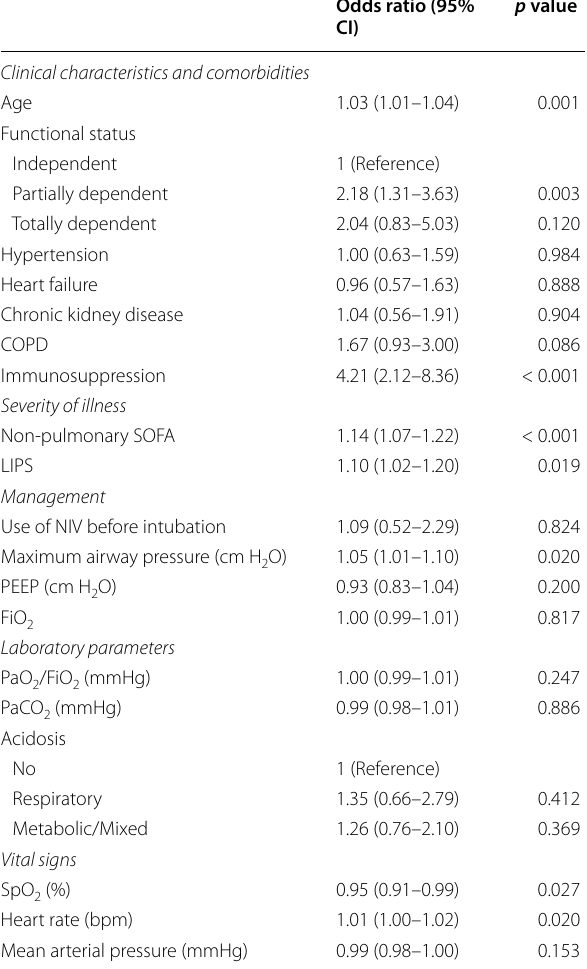
Table 3 Factors associated with in-hospital mortality in patients without ARDS receiving mechanical ventilation